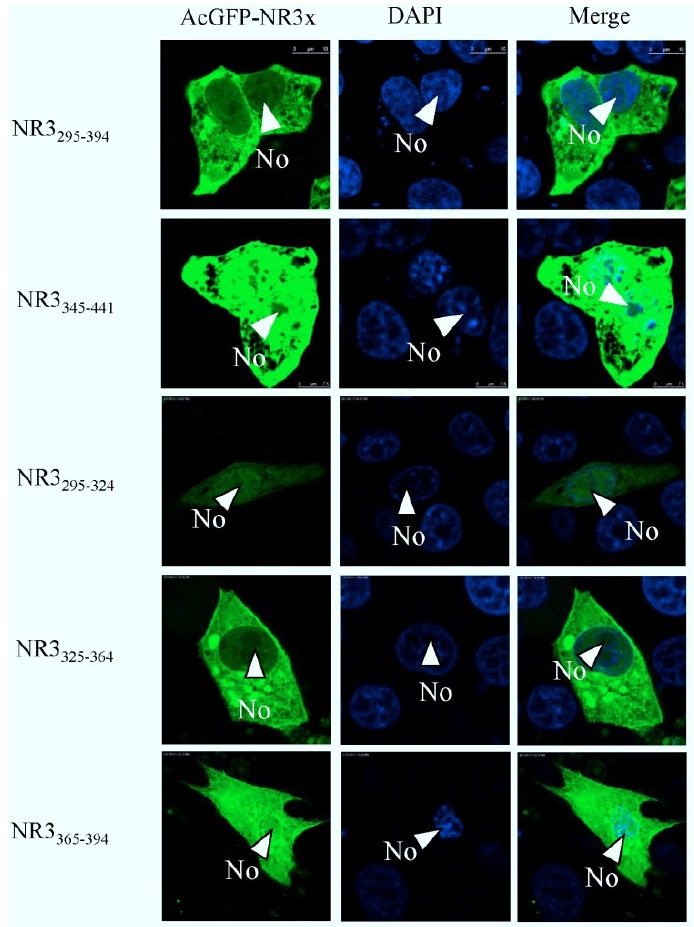
Figure 10. Confocal microscopy of the sub-cellular localization of fluorescent fusion proteins: AcGFP-N and AcGFP-N AcGFP-N , AcGFP-N , AcGFP-N . 295–394 345–441 295–324 325–364 365–394 Fusion proteins are colored green and nucleus colored blue. Merged images are also presented. The nucleolus (No) is arrowed where